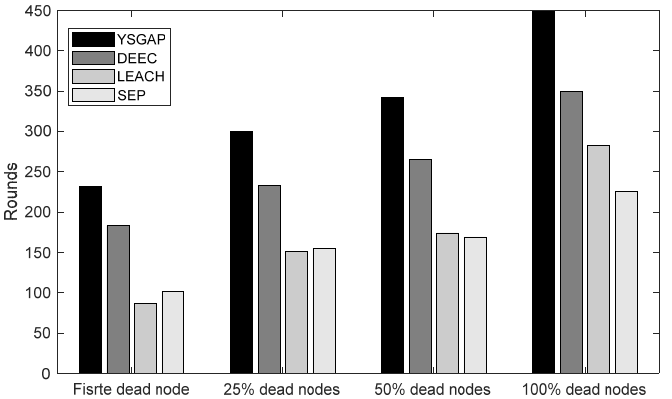
Figure 4. Network lifetime: percentage of dead nodes.